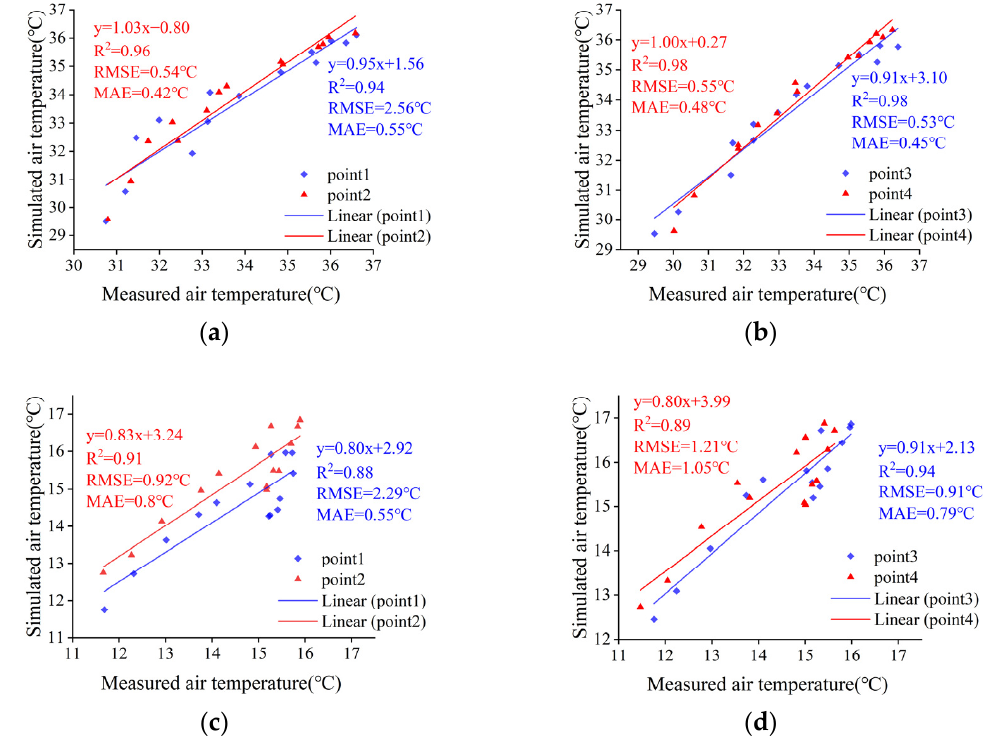
Figure 7. Relationship between the simulation and measurement of air temperature. ( a ) Points 1 and 2 in summer, ( b ) points 3 and 4 in summer, ( c ) points 1 and 2 in winter, and ( d ) points 3 and 4 in winter.